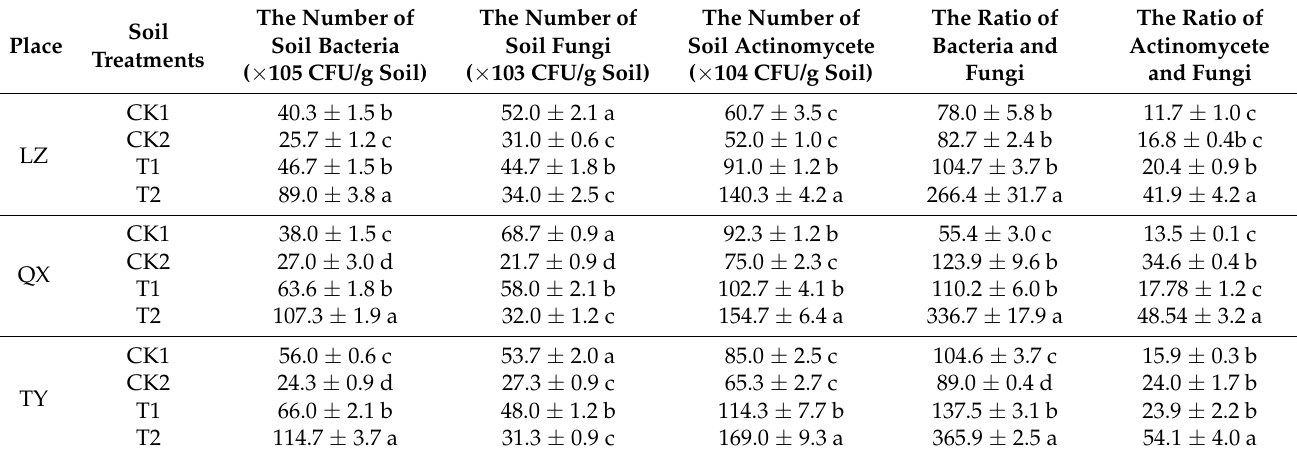
Table 3. Effects of different treatments on the density of microorganisms in the rhizosphere of young apple trees in three